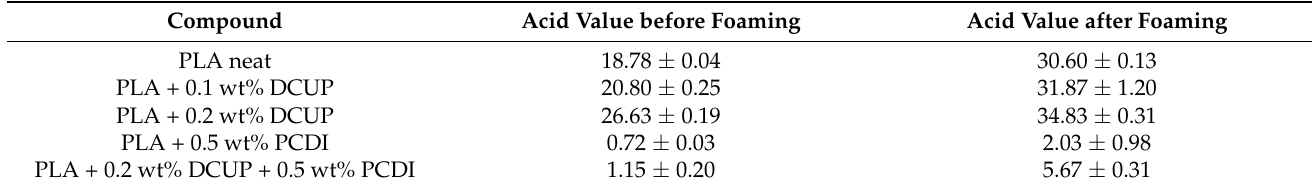
Table 1. Determined acid values in